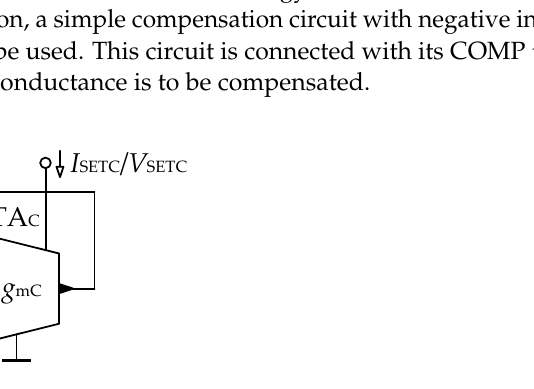
Figure 6. Circuit with grounded negative conductance at terminal COMP.